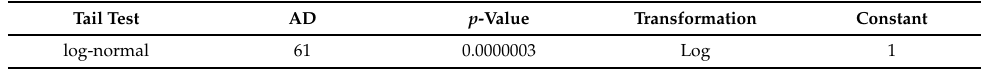
Table 11. Tail: AD GoF test—batch by bundle.